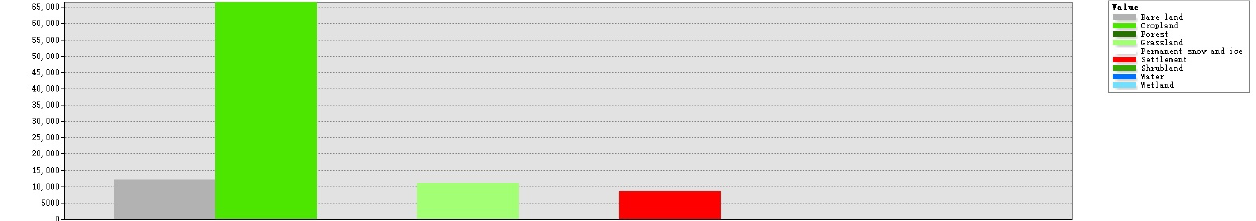
Figure 15. Histograms of LULC in 2020 in zones of the area where the shafts existed in 1970 and disappeared in 2020. The vertical axis is in